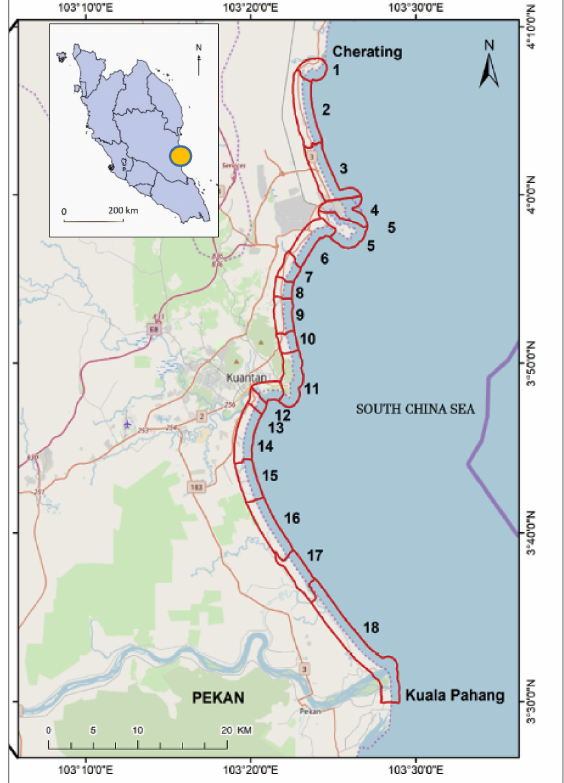
Figure 9. Coastal vulnerability impact (CVI) assessment along the Cherating–Pekan coast [85]. ‘Reprinted with permission from Comprehensive coastal vulnerability assessment and adaptation for Cherating—Pekan coast, Pahang, Malaysia [85], 2019; published by Elsevier, License Number 5071141176280, Date 17 May